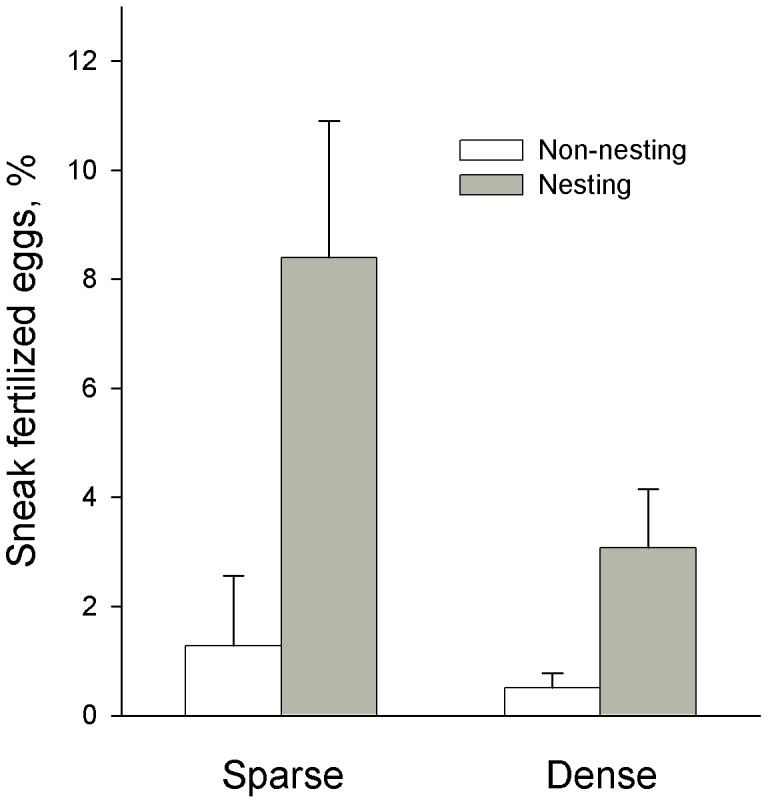
Mean (+ SE) proportion of eggs that were sneak fertilized by non-nesting and nesting males, in pools with sparse and dense vegetation.Untransformed values are presented.